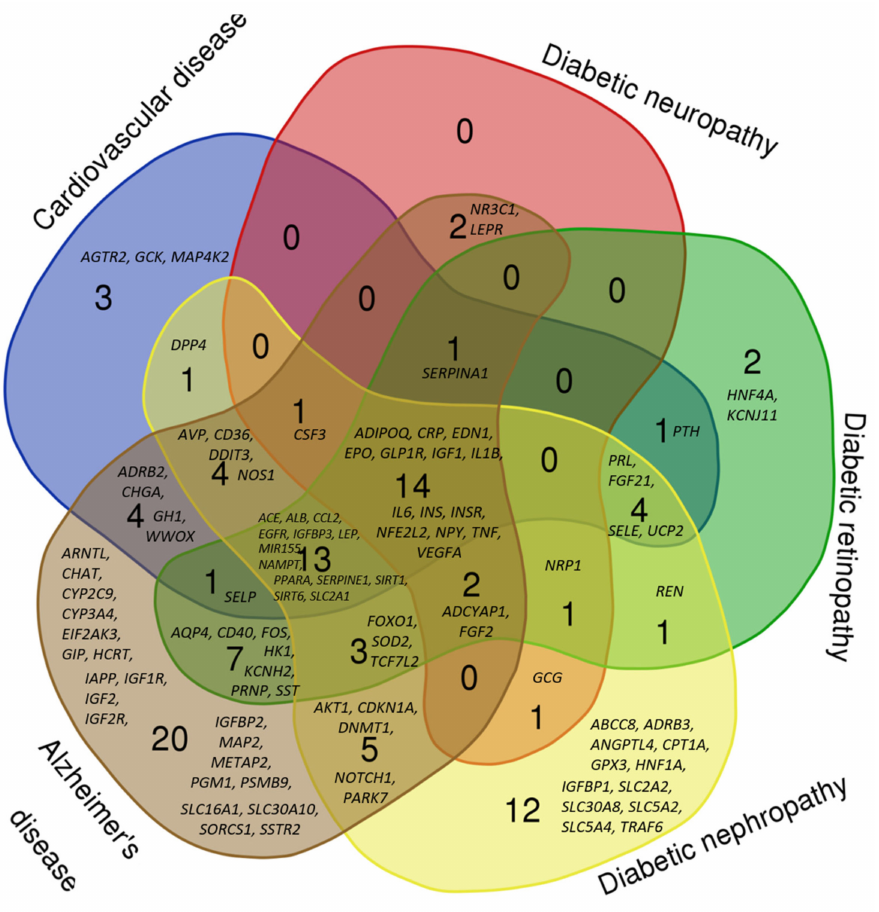
Figure 3. Venn diagram of intersection of gene sets associated simultaneously with hypoglycemia and cardiovascular disease, diabetic neuropathy, diabetic retinopathy, diabetic nephropathy, and Alzheimer’s disease. Table 4. Gene ontology biological processes that are overrepresented simultaneously for the gene sets associated with